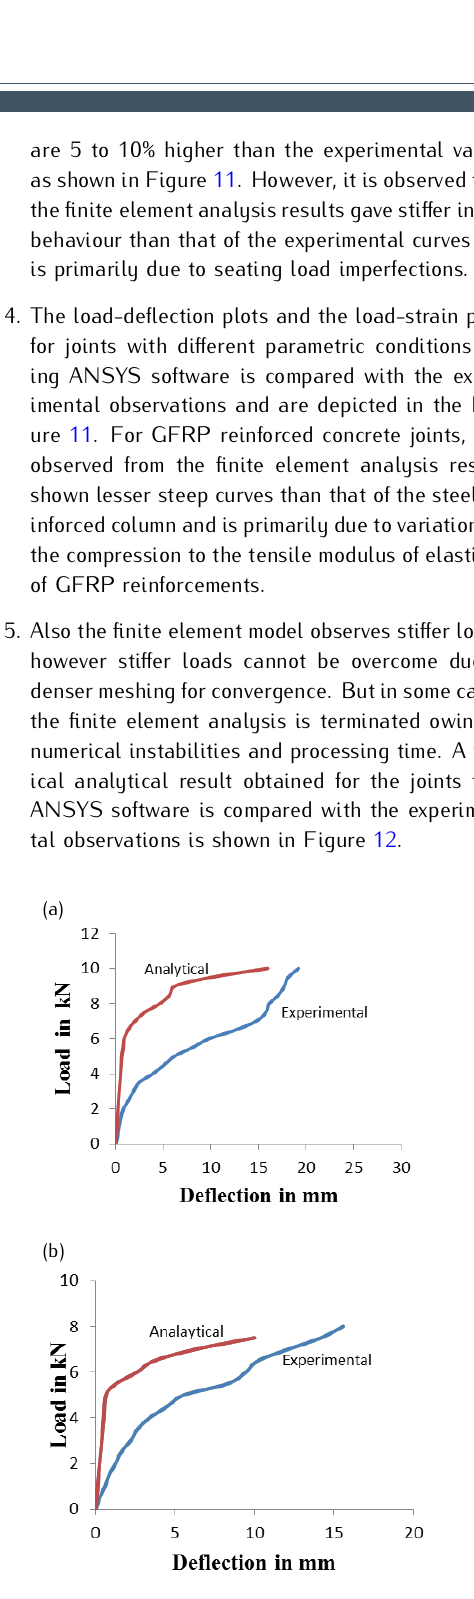
Figure 11. Typical Load- Deflection curves for A series specimens (a) Control Specimens; (b) GFRP